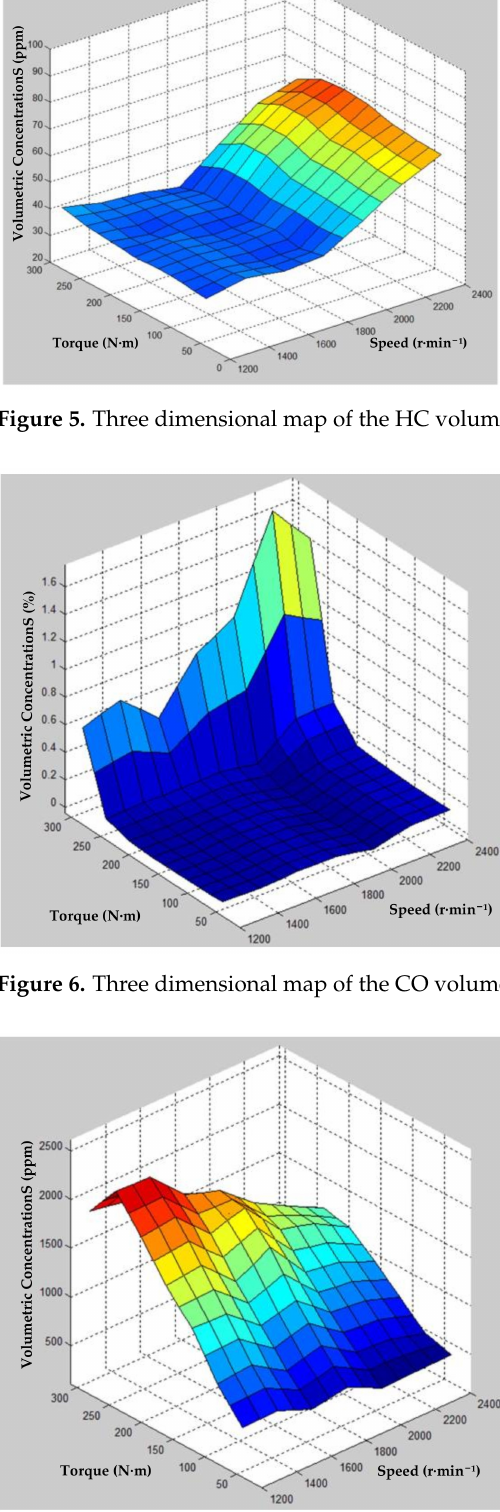
Figure 7. Three dimensional map of the NOx